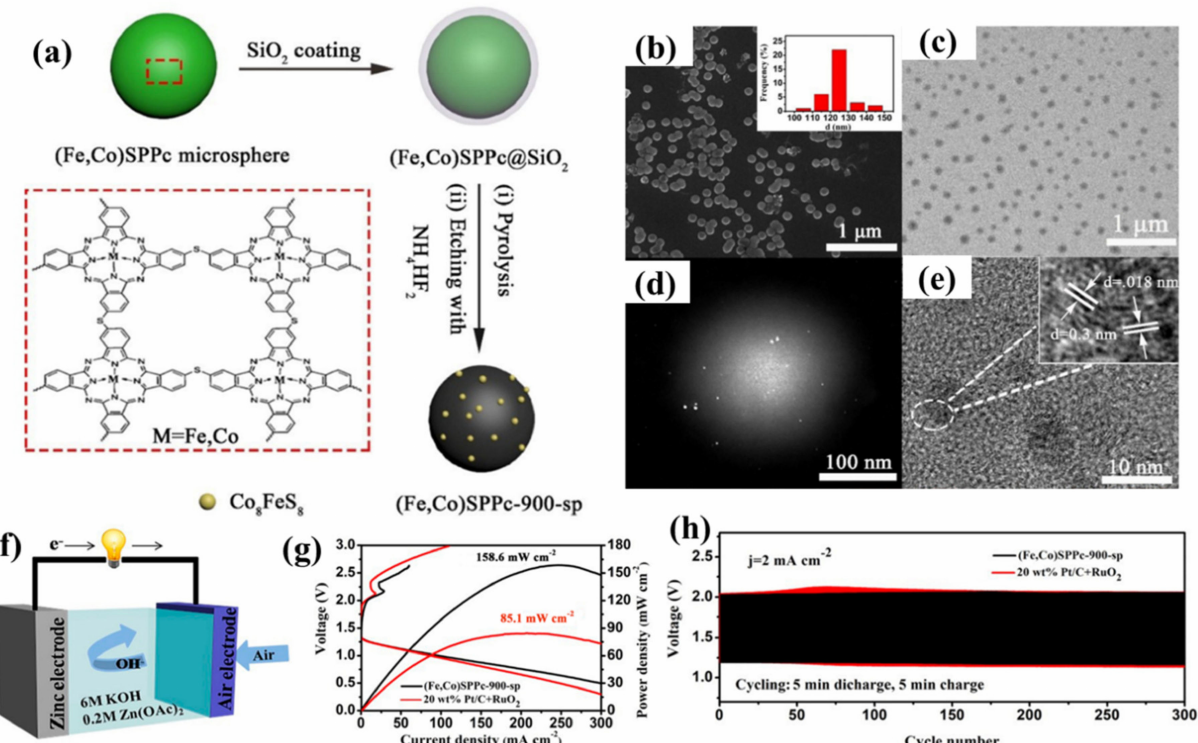
Figure 16. ( a ) Synthetic technique for nanoporous (Fe,Co)SPPc-900-sp and other (Fe,Co)SPPc-T-sp and control materials. ( b ) SEM picture of (Fe,Co)SPPc-900-sp, demonstrating particle size